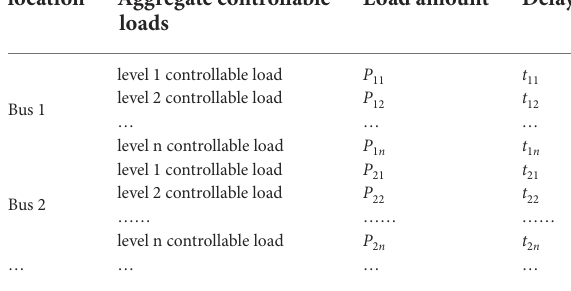
TABLE 2 Results of controlled load aggregation.